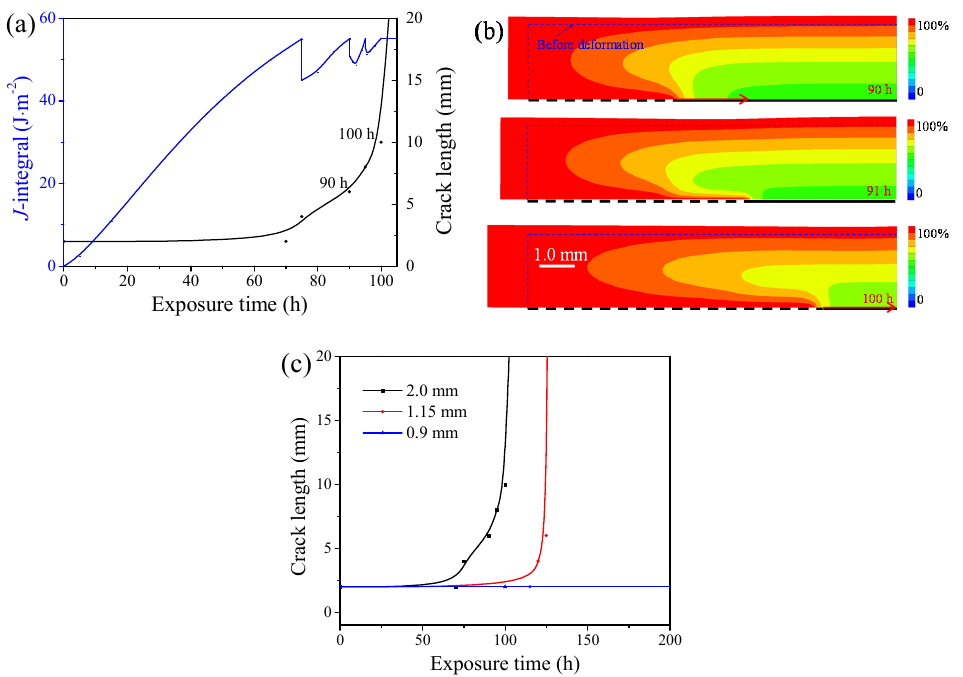
Figure 12. ( a ) J i and crack length plotted against a humid environment exposure time. ( b ) Wetness contour and deformation of 2 mm thick coating layer while exposing for 90, 91 and 100 h. The displacement was magnified 20 times in the deformed model shape. ( c ) The effect of coating thickness on interfacial crack growth.